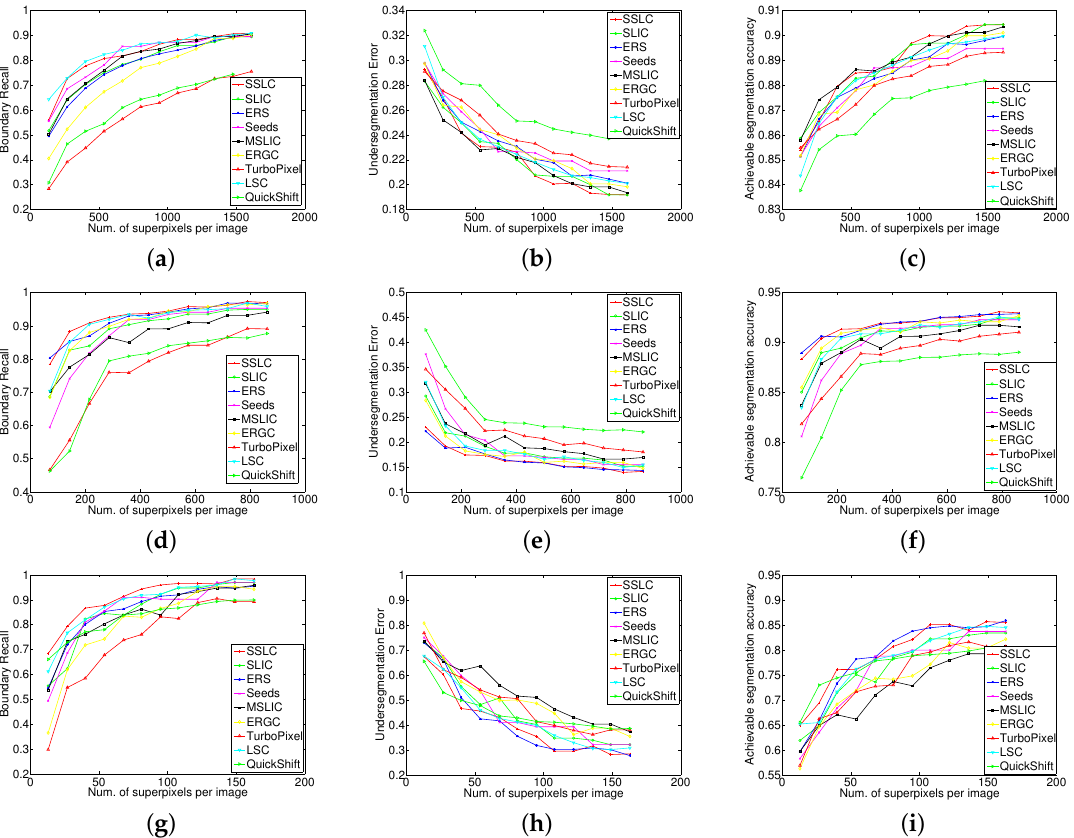
Figure 12. Performance comparison of the proposed algorithm and the other tested ones on remote sensing images. ( a ) PaviaU BR; ( b ) PaviaU UE; ( c ) PaviaU ASA; ( d ) Salinas BR; ( e ) Salinas UE; ( f ) Salinas ASA; ( g ) Indian Pines BR; ( h ) Indian Pines UE; ( i ) Indian Pines